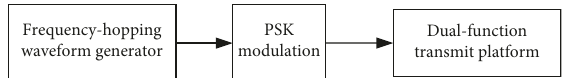
Figure 1: Illustrative diagram of a dual-function transmitter using FH waveform and PSK